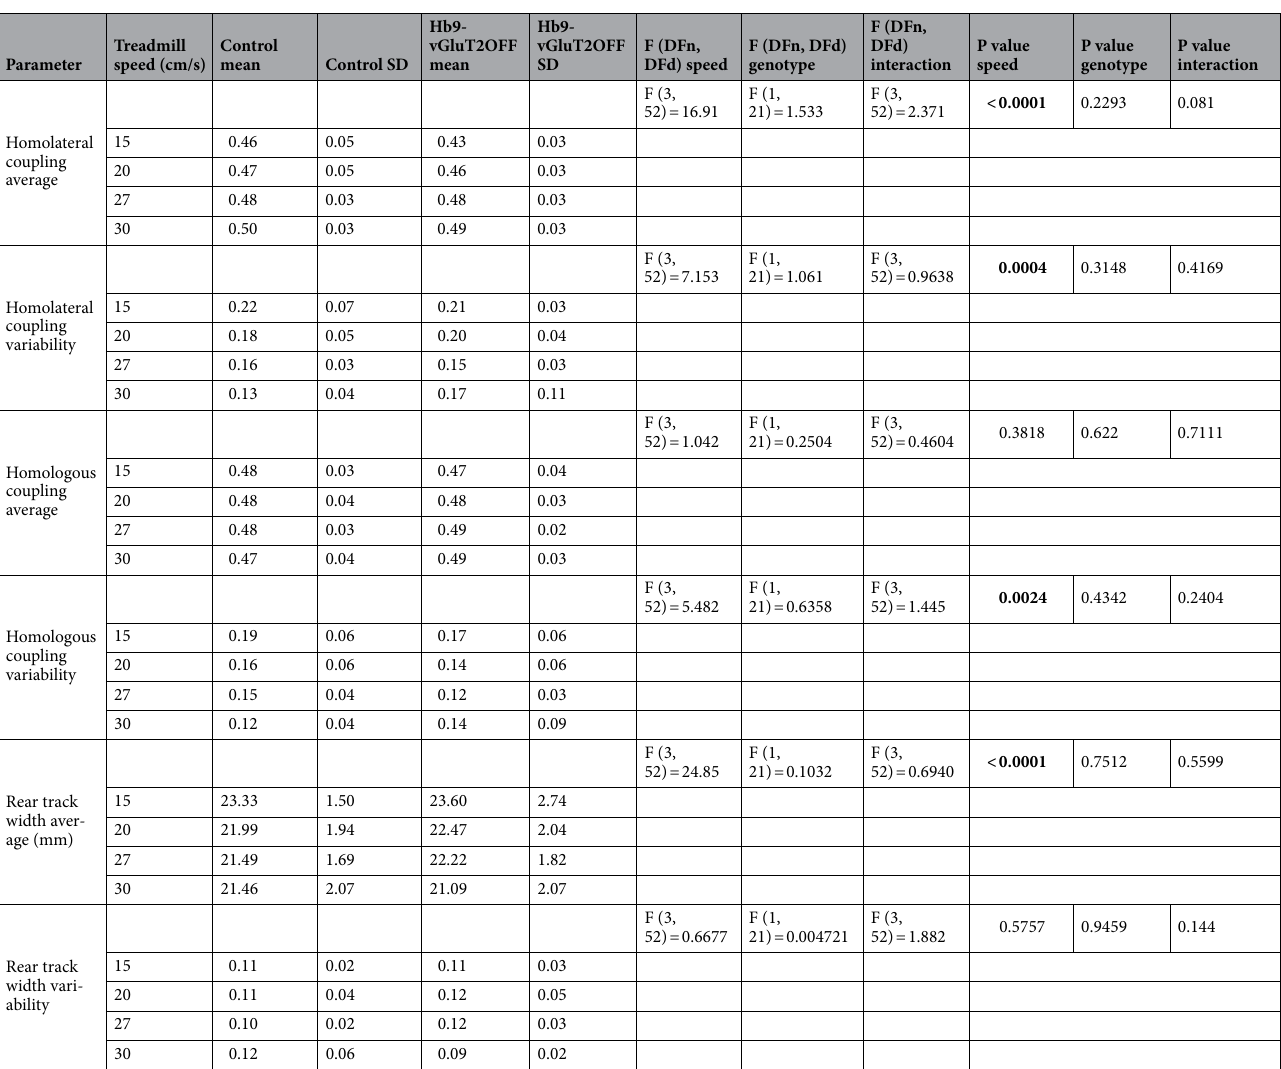
Table 1. Statistics for treadmill locomotion pattern parameters. Repeated measures two way ANOVA. Bold indicates significant P values. See “Methods” for